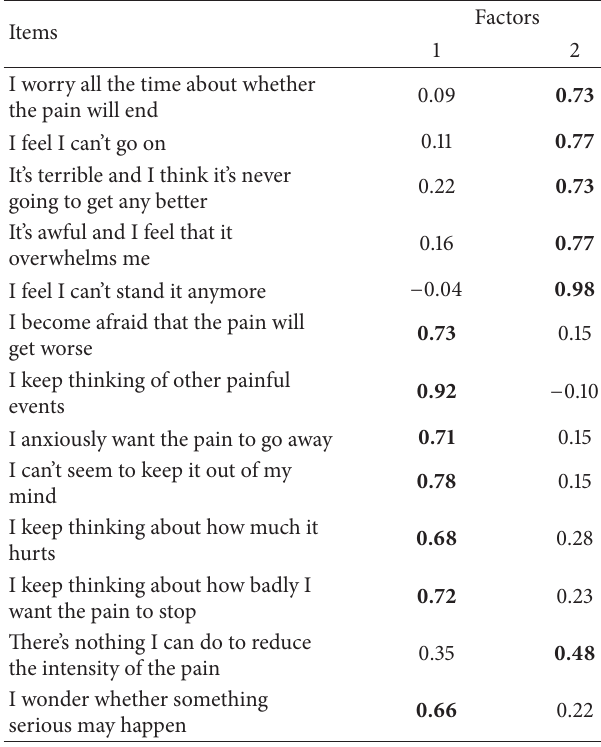
Table 1: EFA using principle axis factoring and promax rotation.